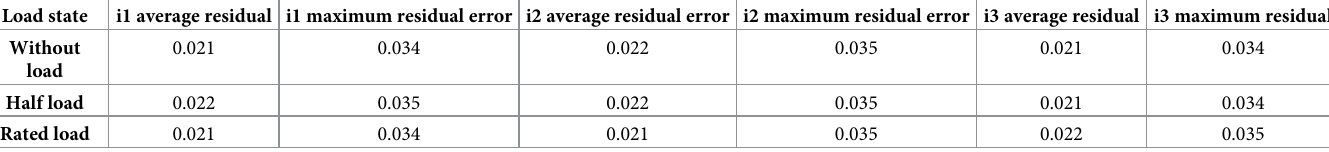
Table 4. Comparison of residual current of each sensor under different